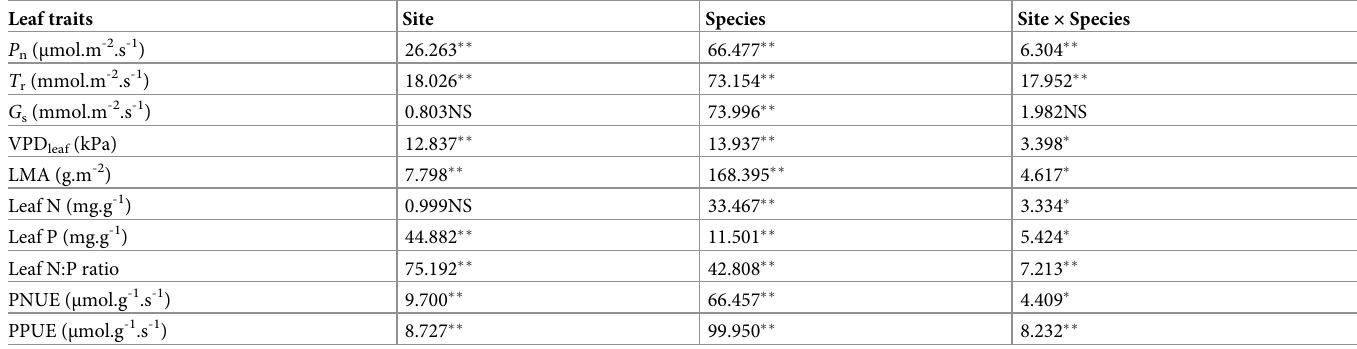
F -ratios are shown in the table �� indicates significant at 0.01 level � indicates significant at 0.05 level, NS indicates no significant